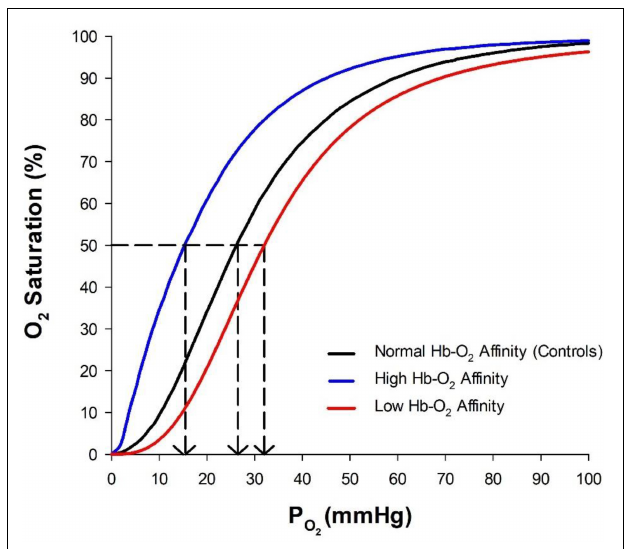
FIGURE 1 | Oxygen dissociation curve showing normal hemoglobin-O 2 (Hb-O 2 ) affinity (P 50 ∼ 26 mmHg), high Hb-O 2 affinity (P 50 ∼ 16 mmHg), and low Hb-O 2 affinity (P 50 ∼ 32 mmHg). The P 50 , denoted by the dashed lines, is defined as the P O at which 50% of hemoglobin is saturated with O 2 2